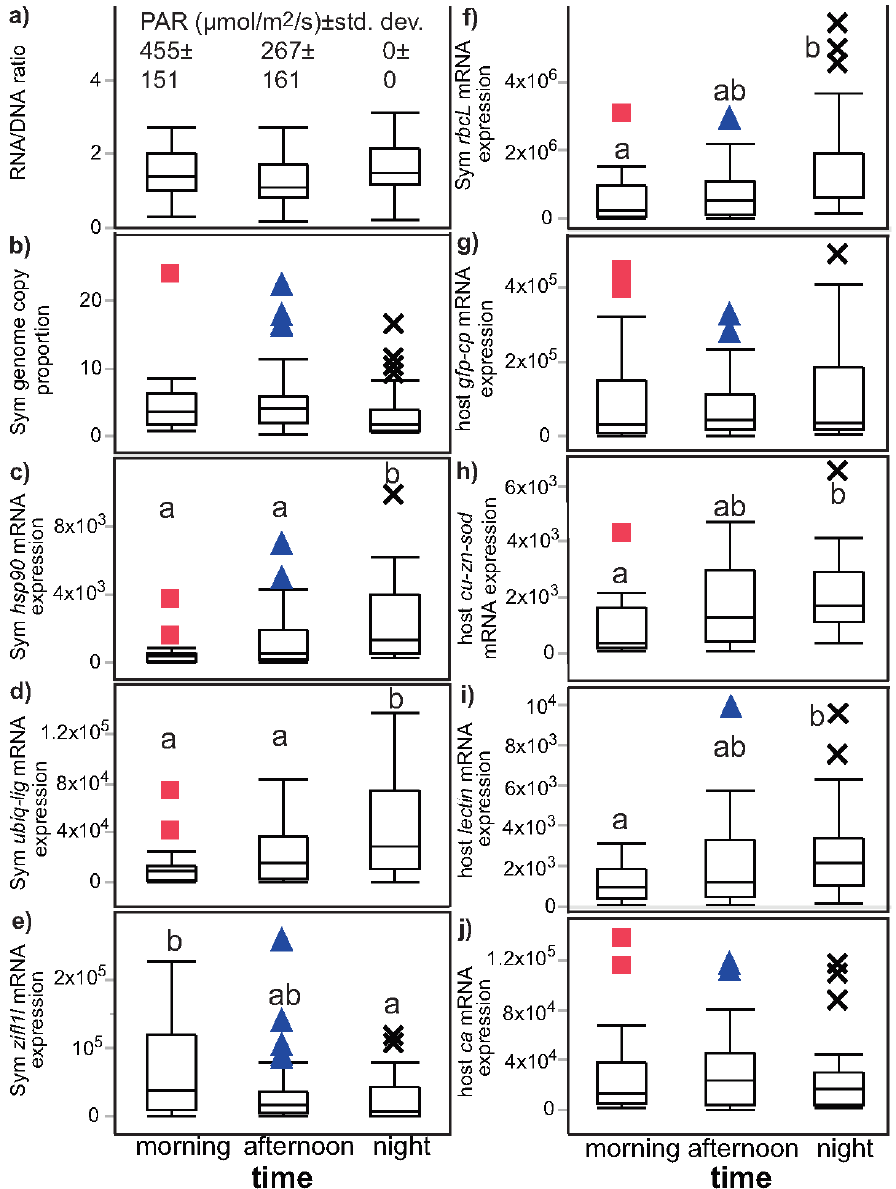
Figure 2. Sampling time effects on the 10 pocilloporid coral-Symbiodiniaceae response variables. When the Wilcoxon test determined a statistically significant effect of time (df = 2; squares, triangles, and exes for morning (before 10:00), afternoon (10:00–14:00), and night (after 18:00), respectively) for any of the 10 response variables ( a – j ), rank-based post-hoc tests (i.e., Dunn’s joint-ranking tests) were carried out among individual sampling time means ( p < 0.05; as lowercase letters). Mean PAR levels for each sampling bin are included at the top of panel a.